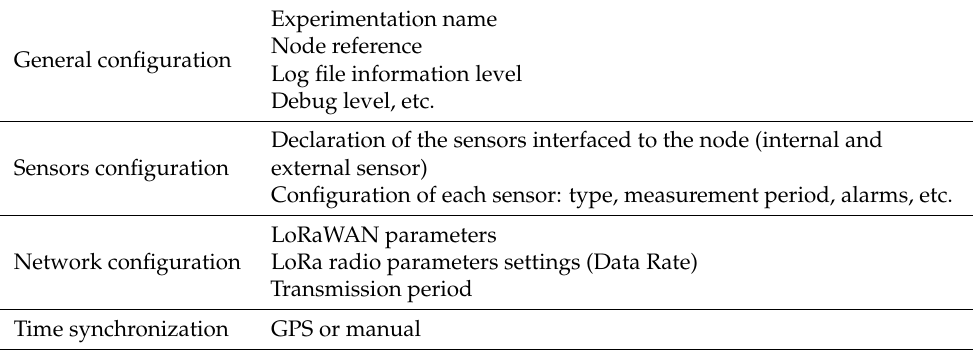
Table 1. Parameters to be defined in the configuration file.